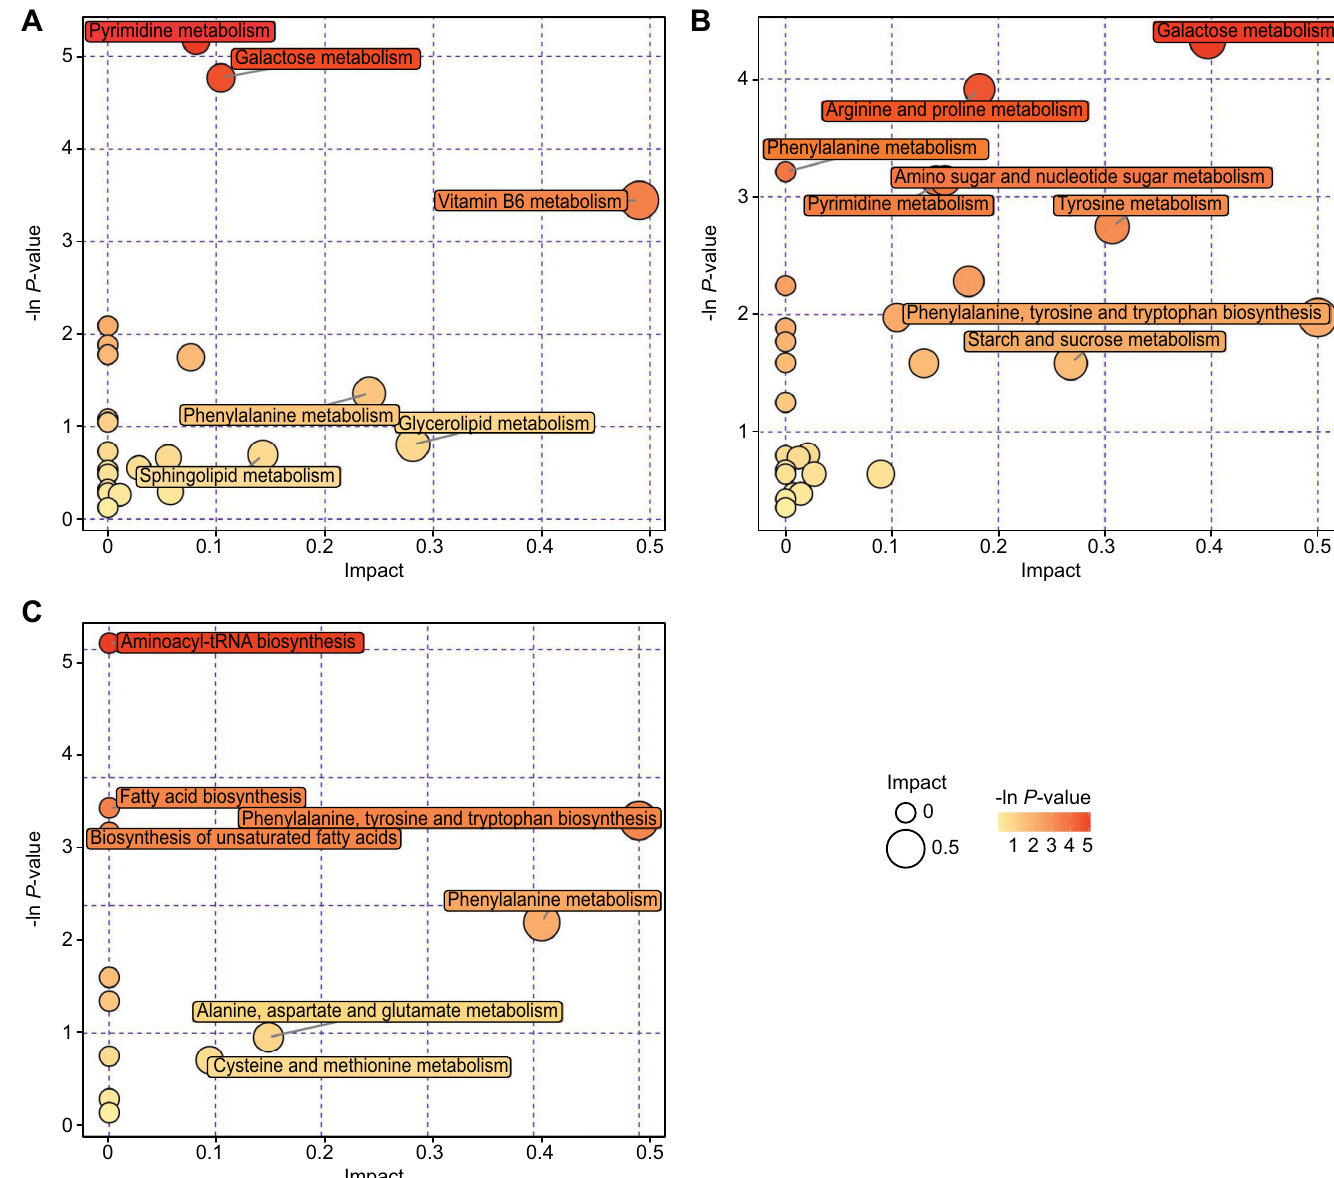
Fig 5. Bubble plots of the metabolic pathway analysis for the LCD vs . HCD groups. A and B were respectively derived from POS and NEG of the rumen fluid, and C was derived from NEG of the plasma samples. Each bubble in the bubble map represents a metabolic pathway. The x-axis represents a pathway impact value in the topology analysis, and larger bubbles represent higher pathway impact values. The y-axis represents the P -value (-ln p ) of the metabolic pathway in the enrichment analysis, and the darker color of bubble represents higher pathway enrichment. https://doi.org/10.1371/journal.pone.0208031.g005 three metabolic pathways were found (POS: 24; NEG: 29) (S3 Table). The impact values of five pathways in POS were greater than 0.1. The impact values of vitamin B6 metabolism; glyceroli- pid metabolism; phenylalanine metabolism; sphingolipid metabolism and galactose metabo- lism were 0.49, 0.28, 0.24, 0.14 and 0.10, respectively (S3 Table). The impact values of phenylalanine, tyrosine and tryptophan biosynthesis; galactose metabolism; tyrosine metabo- lism; starch and sucrose metabolism; arginine and proline metabolism; terpenoid backbone biosynthesis; pyrimidine metabolism; amino sugar and nucleotide sugar metabolism; alanine,